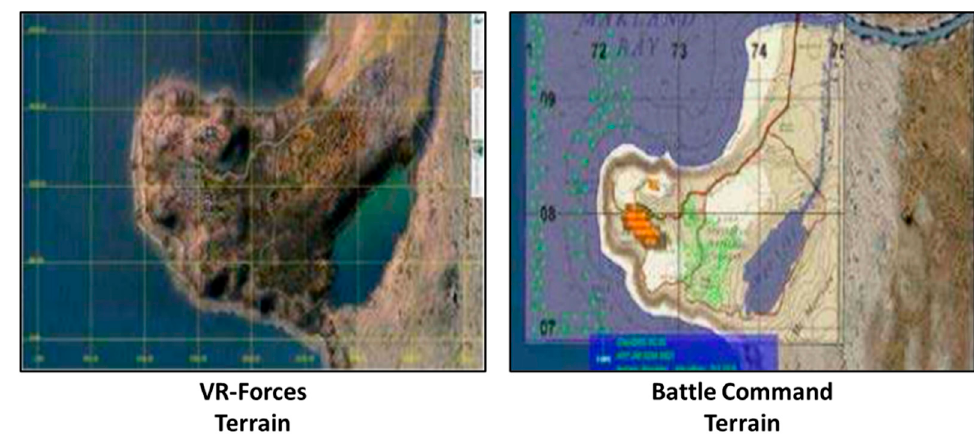
Figure 21. Terrain coherency of COTS simulation tools (adapted from [10]).